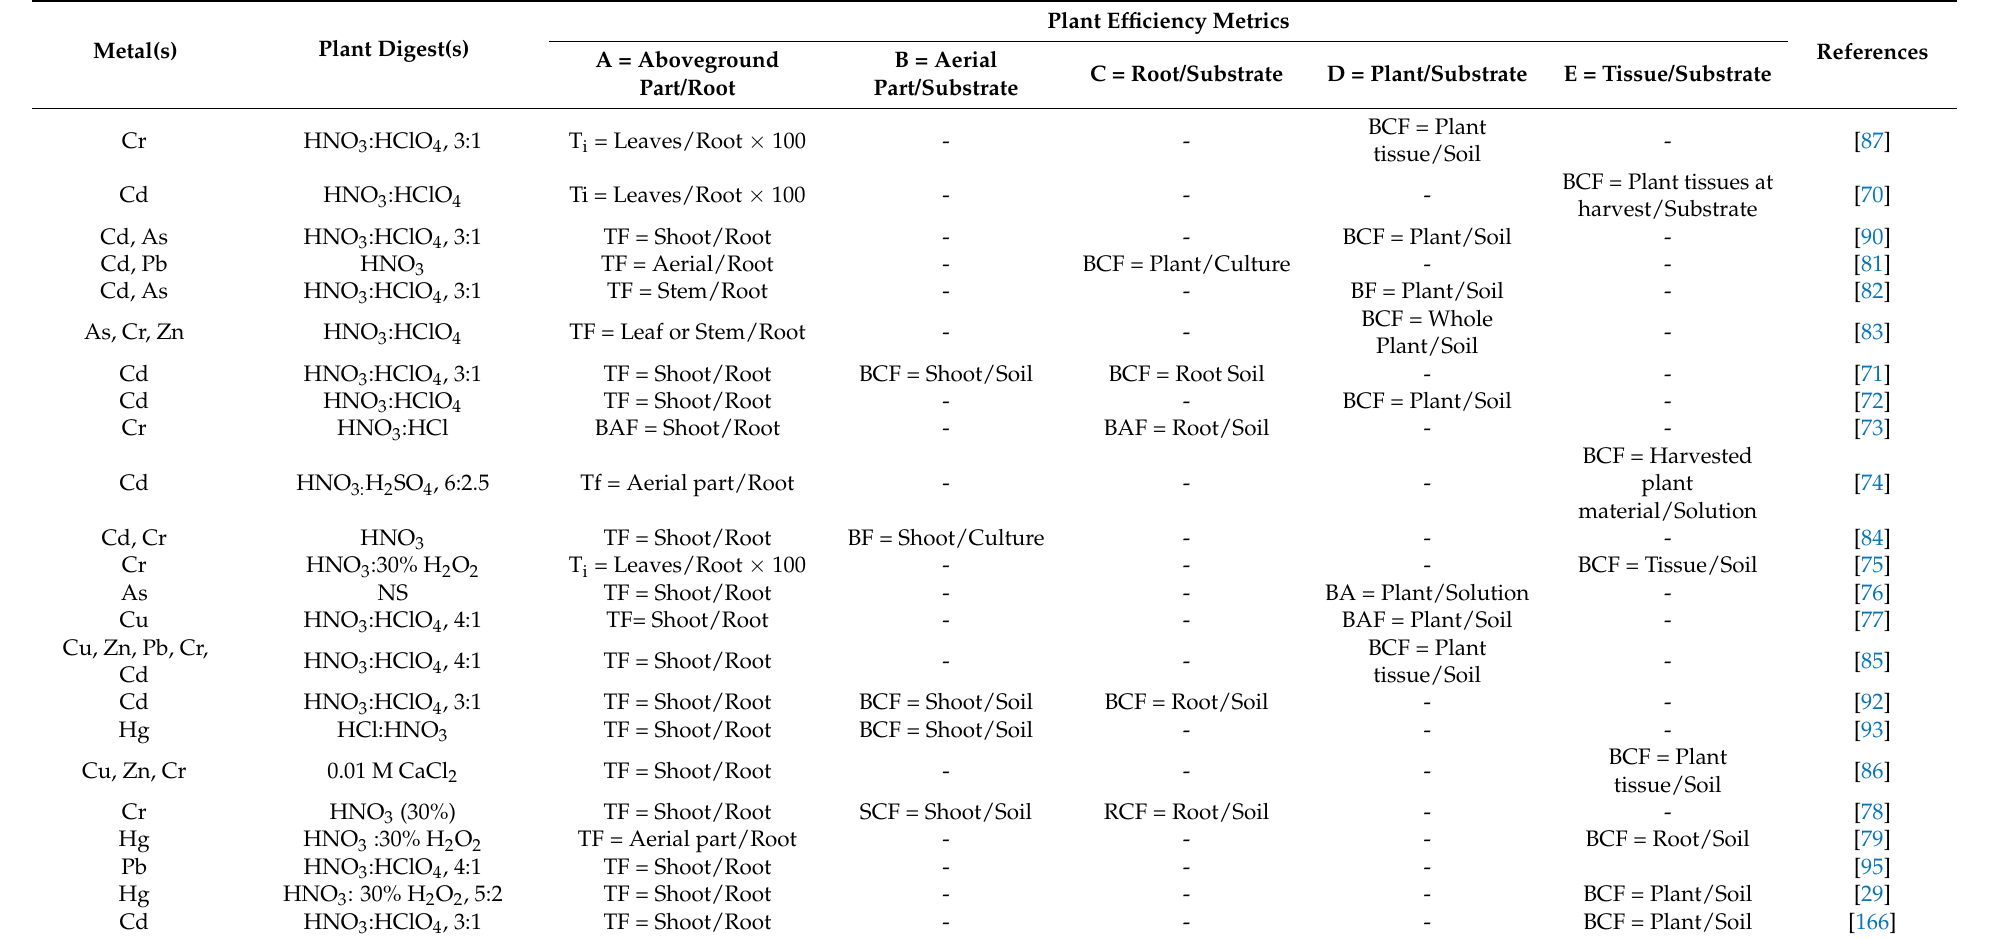
Table 5. List of plants and soil extractants as well as plant efficiency metrics to evaluate the remediation potential of artificially spiked contaminated